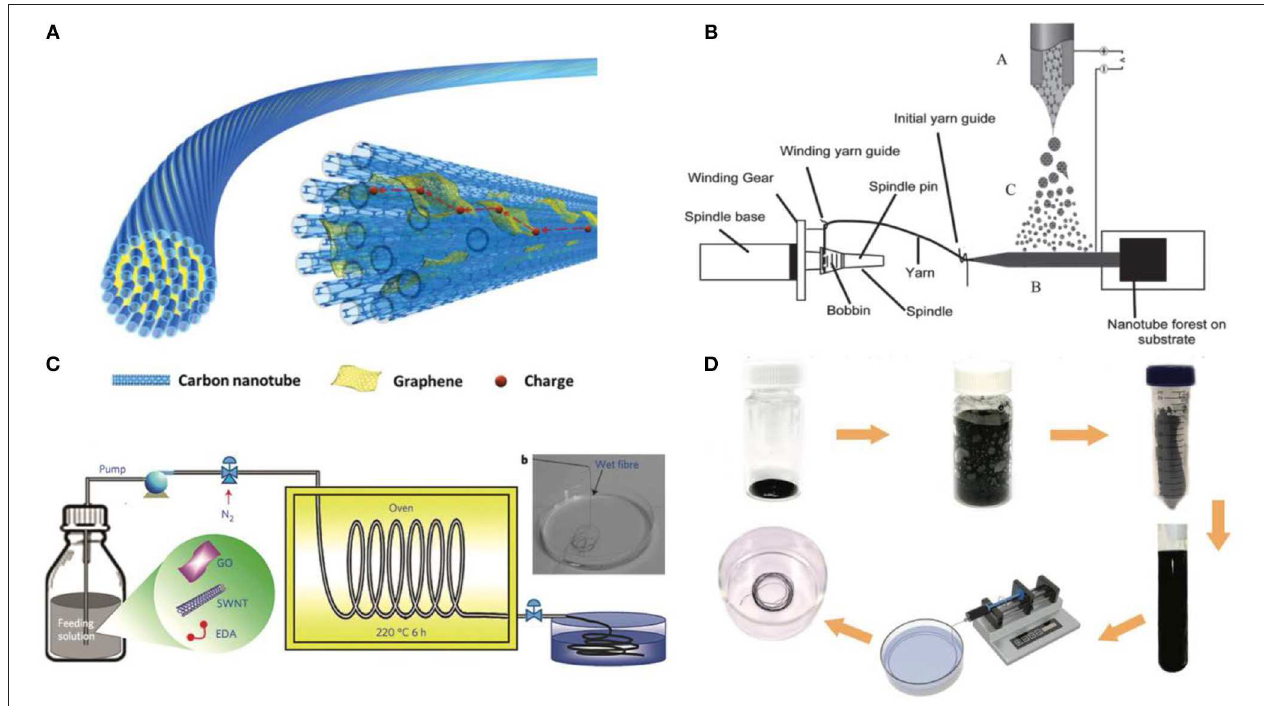
FIGURE 4 | Schematic illustration of (A) solid-spun carbon nanotube fiber with internal graphene sheets (Sun et al., 2014b). (B) Co-spinning of CNT/graphene hybrid fiber with solid-spun and electrospinning methods ( Foroughi et al., 2014). (C) Hydrothermal procedures of rGO/SWNT composite fiber (Yu et al., 2014a). (D) Super-acid exfoliated graphene sheets co-spun with carbon nanotubes (Lu et al.,